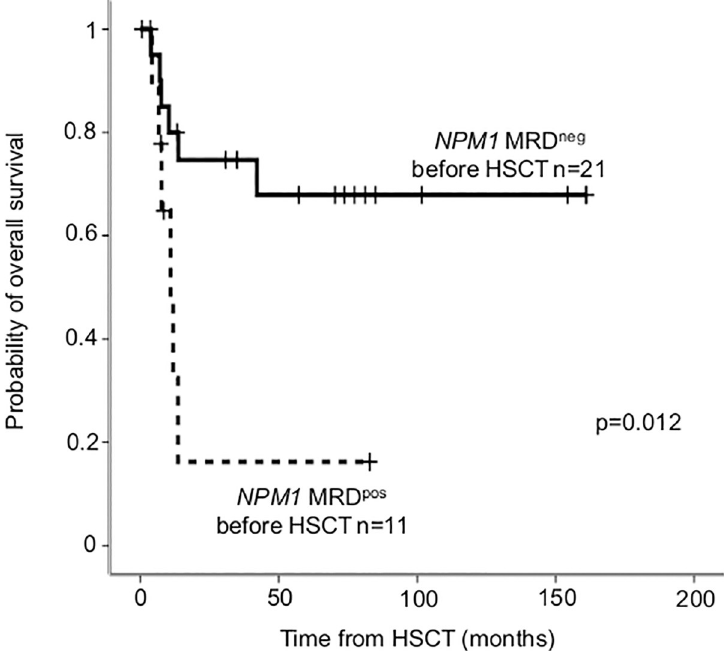
Fig 5. Overall survival according to NPM1 MRD measured before HSCT. NPM1 MRD negativity before HSCT was defined as VAF < 0.01–0.05% depending on mutation type.